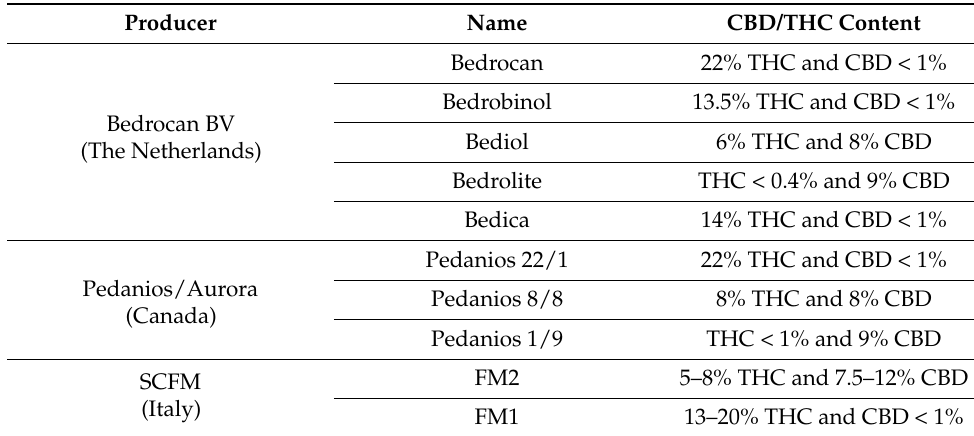
Table 1. Commercially available cannabis